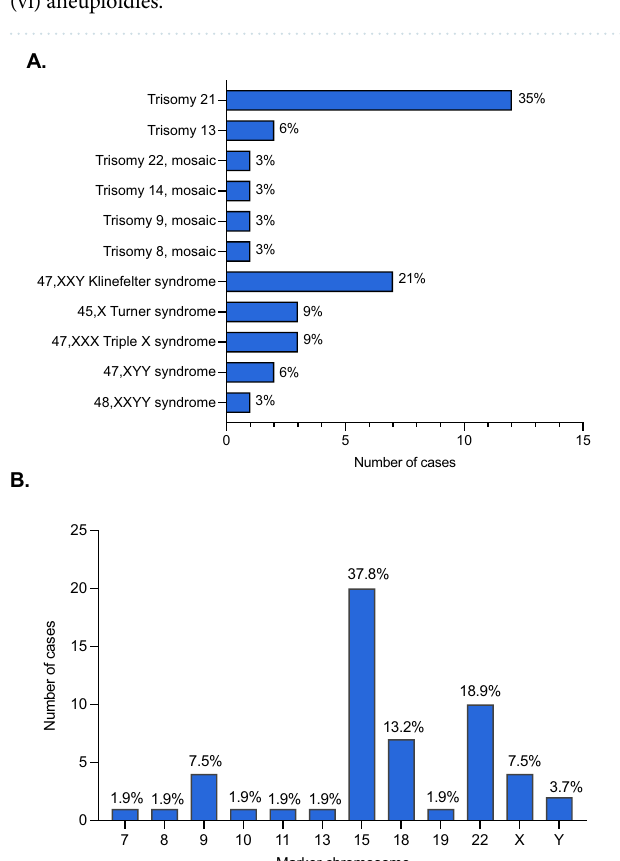
Figure 2. Distribution of the CNVs identified in the cohort. ( A ) It is shown the frequency of variants in each of the three main CNV categories: (i) Pathogenic; (ii) Likely pathogenic and (iii) Variants of Unknown Significance (VUS). ( B ) Distribution of the pathogenic CNVs, displayed by frequency order: (i) known CNV syndromes, (ii) CNV > 4 Mb, (iii) complex rearrangements, (iv) loss-of-function (LoF) MIM gene, (v) marker chromosomes, (vi) aneuploidies.